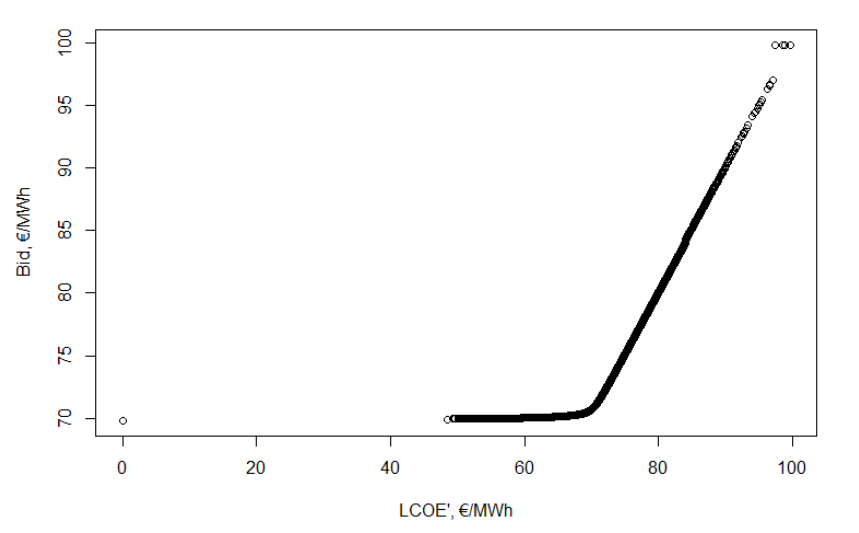
Figure 8. The optimal bid function assuming F 3 bid distribution, source: own figure. After sorting the optimal bids it is clear, that there is no longer a jump between the other. From these sorted bids the new, F 4 bid distribution can be calculated.